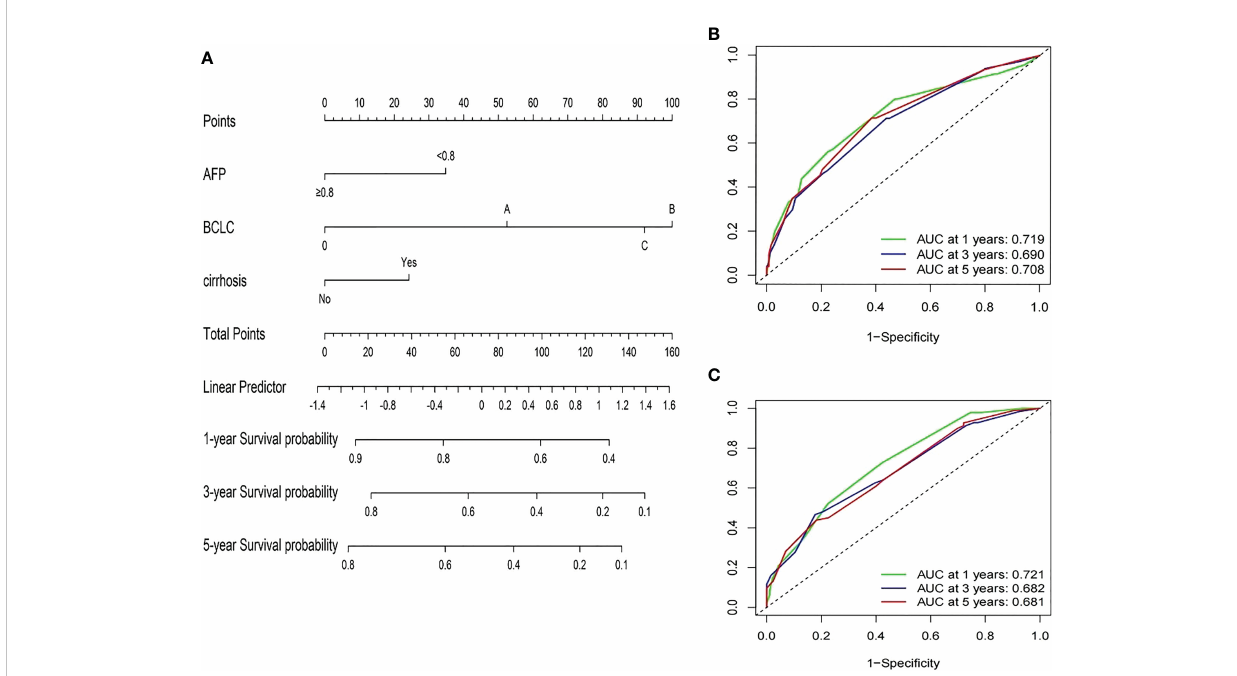
FIGURE 3 Developed prognosis nomogram model for RFS. (A) nomogram for predicting 1-, 3-, and 5-year RFS of HCC patients after curative resection. (B, C) 1-, 3-, and 5-year ROC values of RFS in the training cohort (B) and the validation cohort (C) .